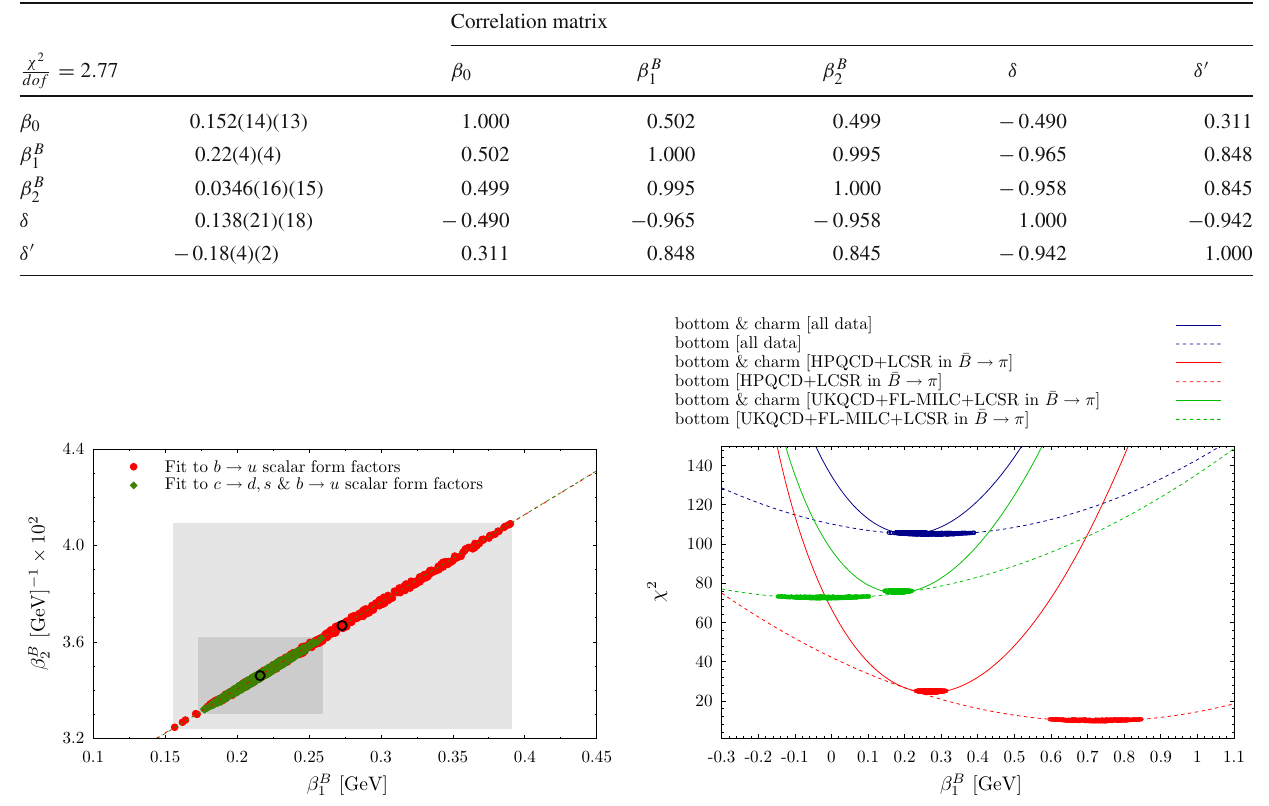
Table 4 Results from the bottom-charm combined fit, with χ 2 defined in Eq. (55) and a total of 38 degrees of freedom. The first set of errors in the best-fit parameters is obtained from the minimization procedure, assuming Gaussian statistics, while the second one accounts for the χ 2 = 2 . 77 dof